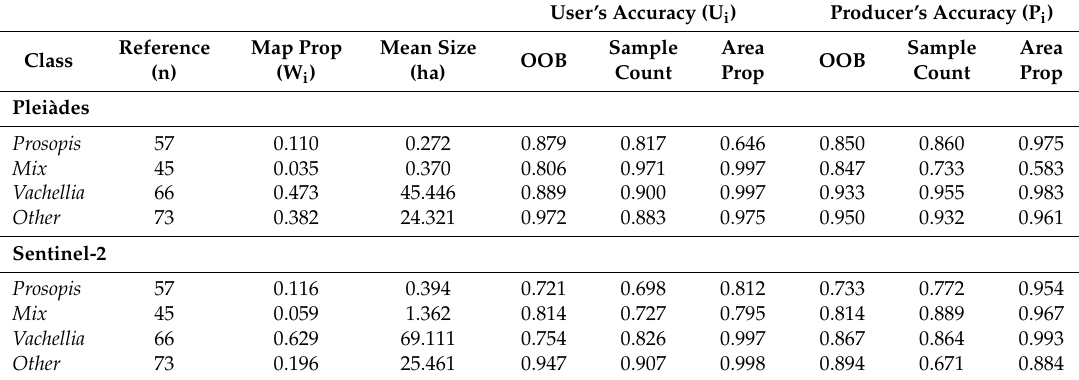
Table 7. Comparison of User’s (U i ) and Producer’s (P i ) accuracy for Out Of Bag (OOB), sample count and area proportionate assessments of the Pléiades and Sentinel-2 classifications. Additionally the number of validation polygons, proportion of the classified map (W i ) and the mean size of the validation polygons are